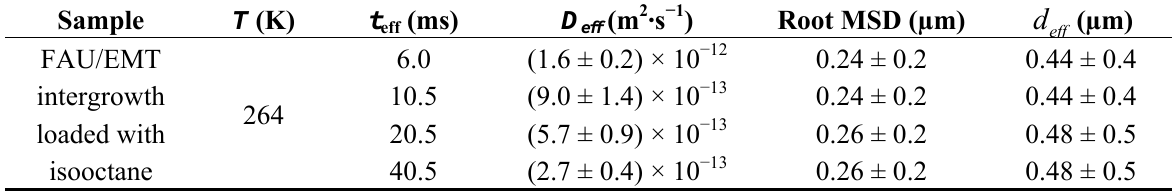
( ) d were obtained by using d . The values of eff eff